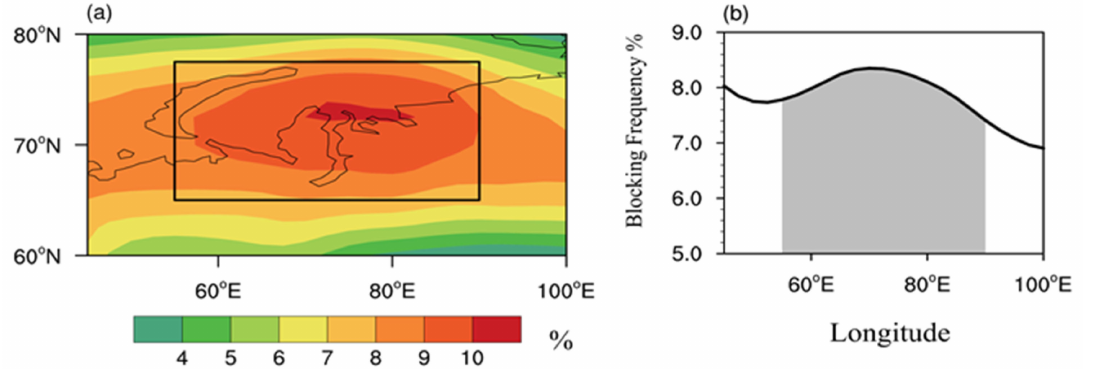
Figure 5. ( a ) Horizontal distribution of Eurasian blocking frequency in the boreal summer; the black boxed area represents the key area (55 ◦ –90 ◦ E, 65 ◦ –77.5 ◦ N). ( b ) The Ural blocking frequency averaged along 55 ◦ –75 ◦ N during summertime; shaded longitude belt (55 ◦ –90 ◦ E) denoting the Ural blocking area; unit: